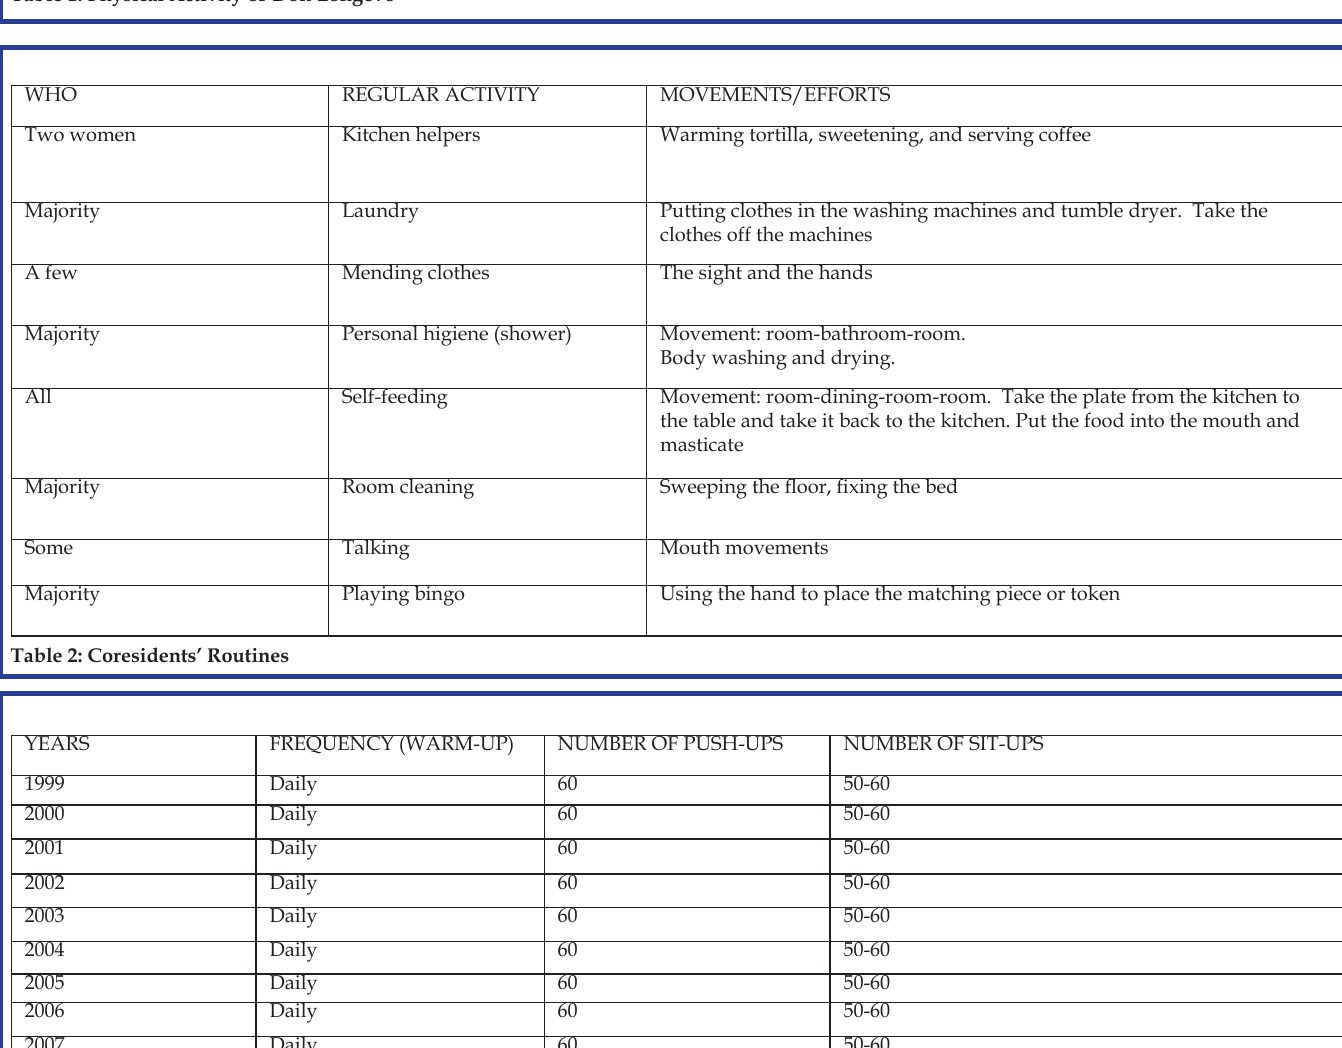
Table 1: Physical Activity of Don Longevo